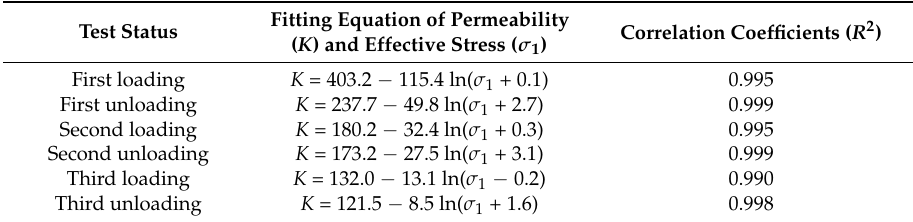
Table 2. The fitting equations of permeability and effective stress on broken coal samples under cyclic loading and unloading conditions.